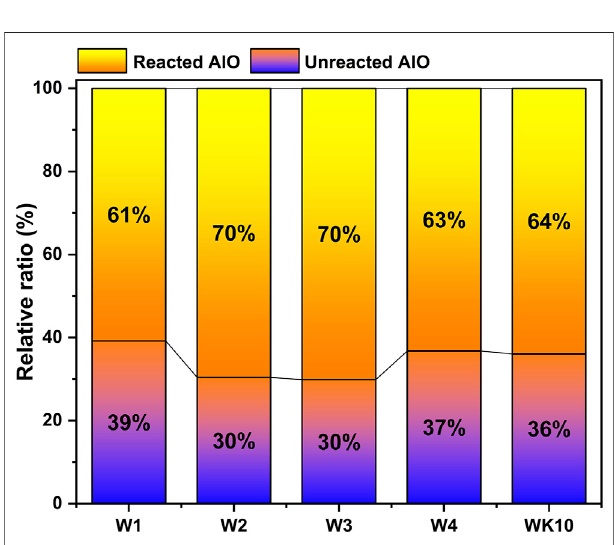
FIGURE 11 | Relative ratio of unreacted and reacted AlO in P-SSC binders at 28 d